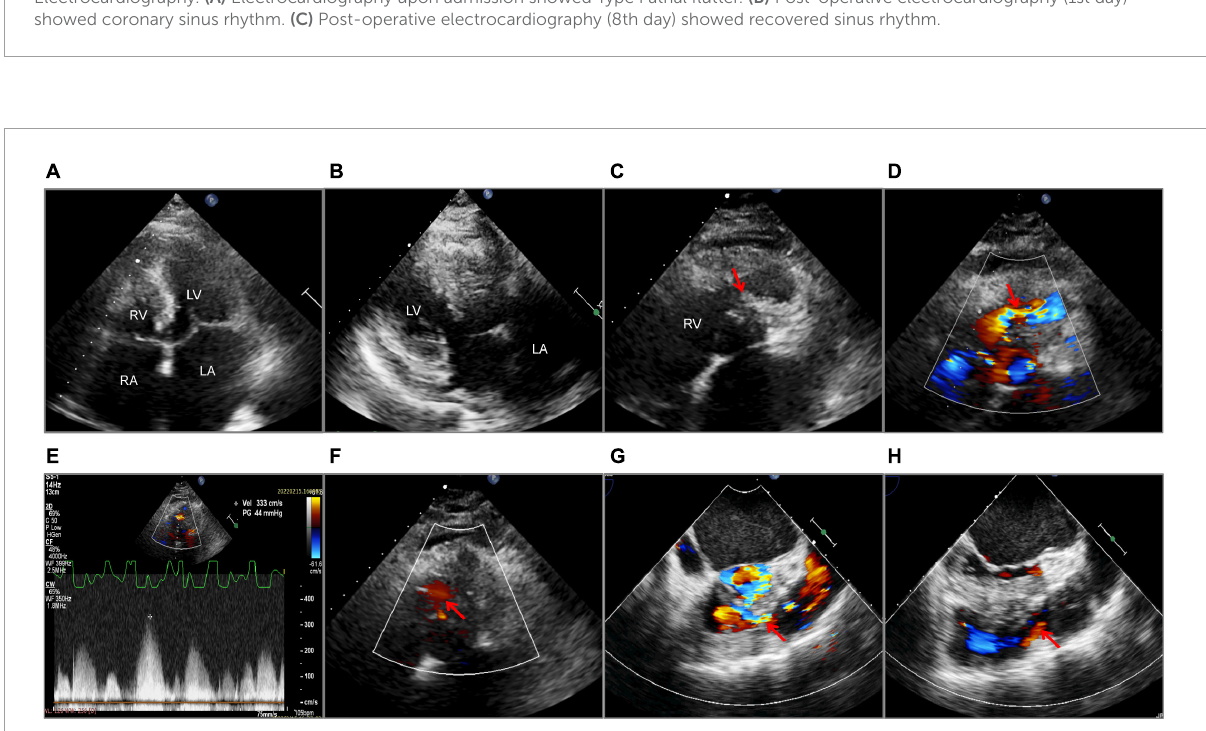
FIGURE2 Echocardiography. Transthoracic echocardiography (A–F) . (A) A 2-D apical four-chamber view with enlarged atria. (B) Left ventricular hypertrophy and interventricular septal hypertrophy. (C) Muscular septation within the right ventricle (the red arrow). (D) Flow acceleration showed by Color Doppler at the right ventricular outflow tract (the red arrow). (E) The systolic pressure gradient of the right ventricular outflow tract. (F) Ventricular septal defect (the red arrow) detected by Color Doppler. Transesophageal echocardiography (G,H) . Color Doppler flow of the right ventricular outflow tract before (G) and after operation (H) , as shown by the red arrows. LA, left atrium; RA, right atrium; LV, left ventricle; RV, right ventricle; Vel, velocity; PG, pressure